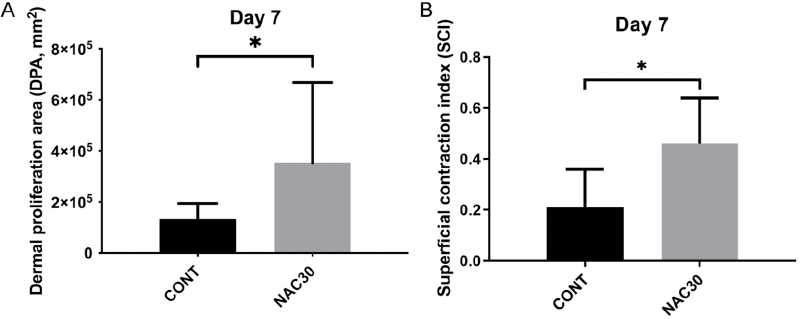
Figure 5. Graph summarizing differences in dermal proliferation area ( A ) and superficial contraction index ( B ) between NAC30 and CONT at day 7. Data expressed as mean ± SD, * p < 0.05.